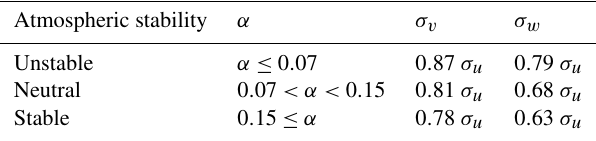
Table 1. Classification of atmospheric stability with power law ex- ponent α . The given wind field parameters σ k are dependent on stability and based on findings by Peña et al. (2010), which is ex- plained in Sect.